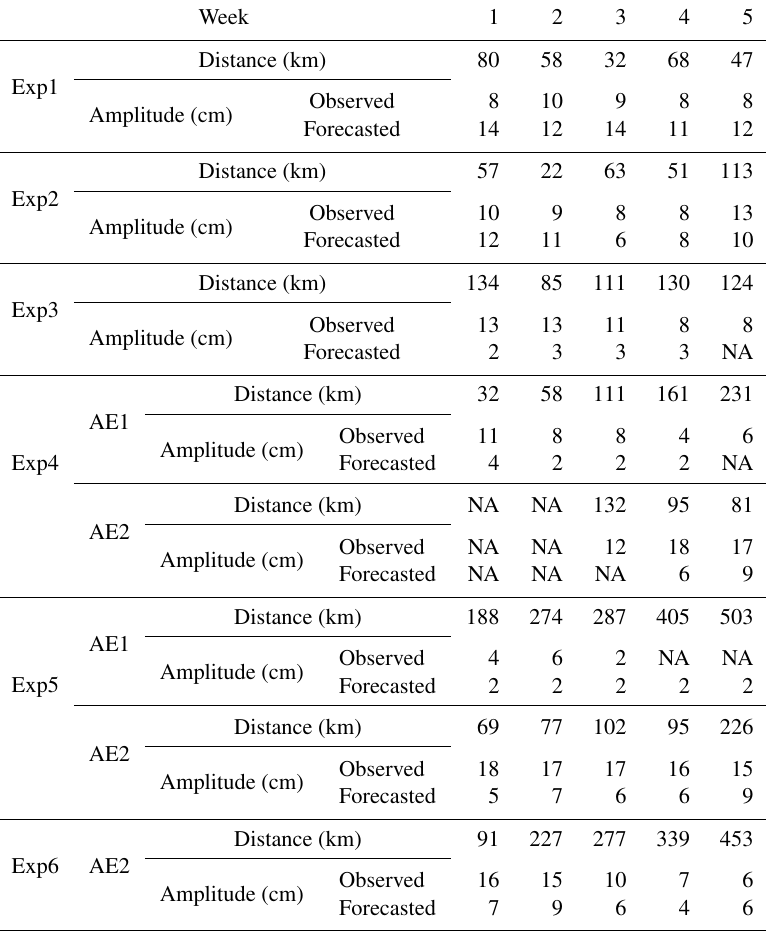
Table 2. The amplitude of AE1 and AE2 derived from observation SLA and the six forecast SLA, and distance of eddy centers between the observation SLAs and forecast